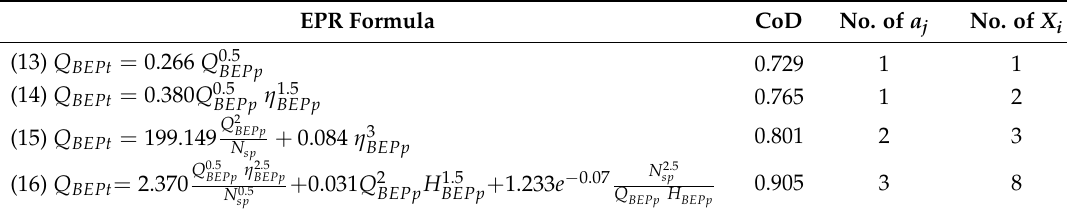
Figure 3. Predicted data versus literature data.